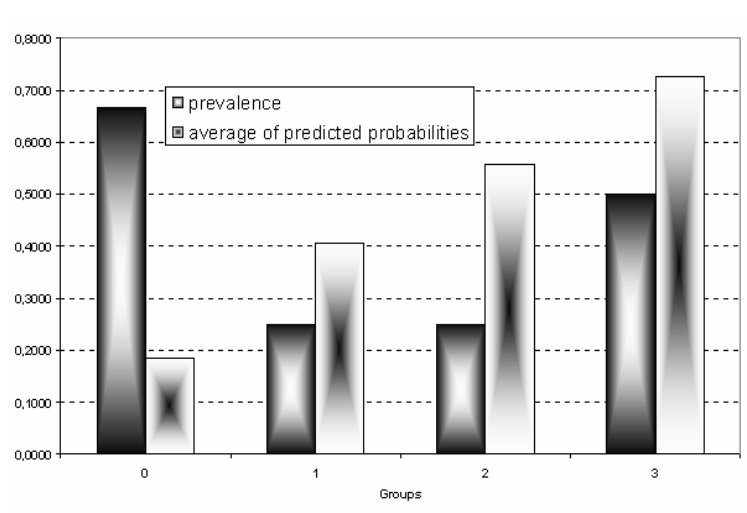
Figure 3 – Calibration bar plot – Validation